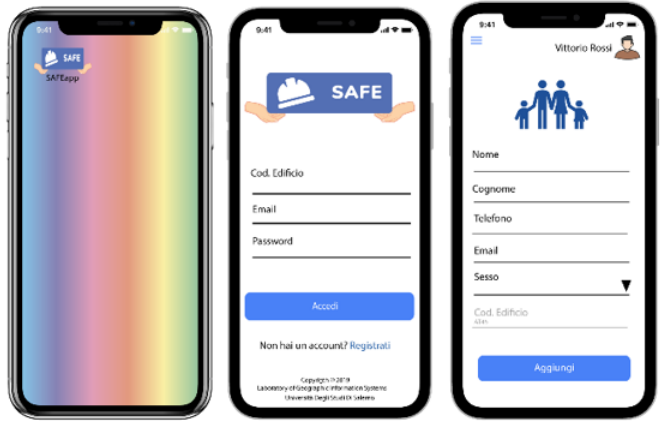
Figure 11. Registering family members.